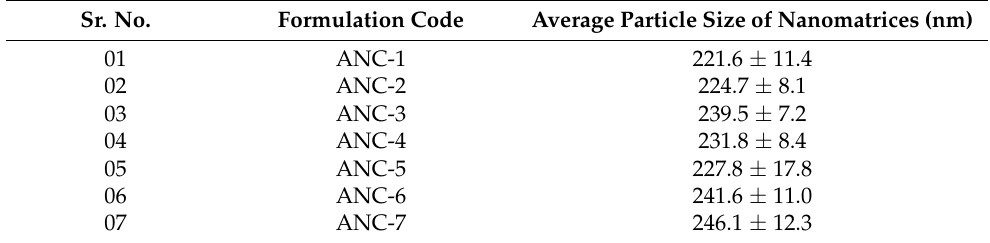
Table 2. Particle size (intensity-weighted average diameters) of the developed nanomatrices. Sr.